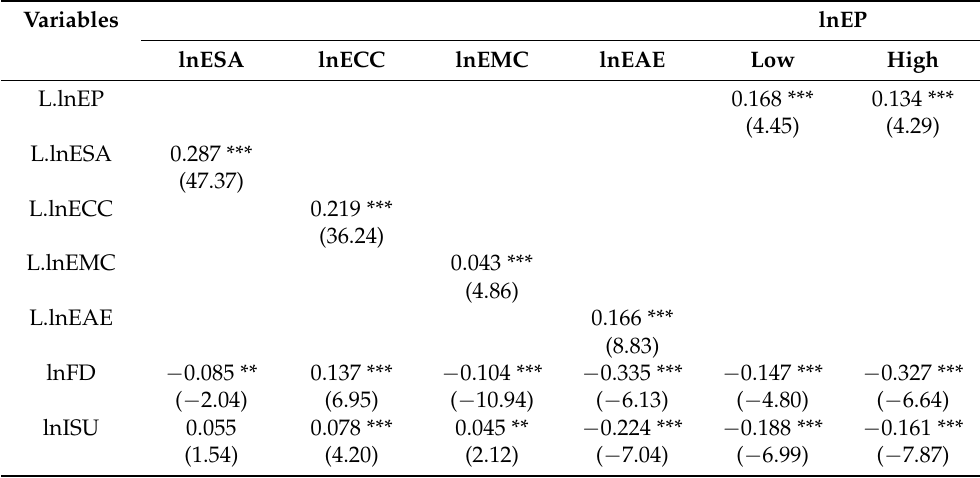
Table 6. Results of the impact of FD on sub-indexes of